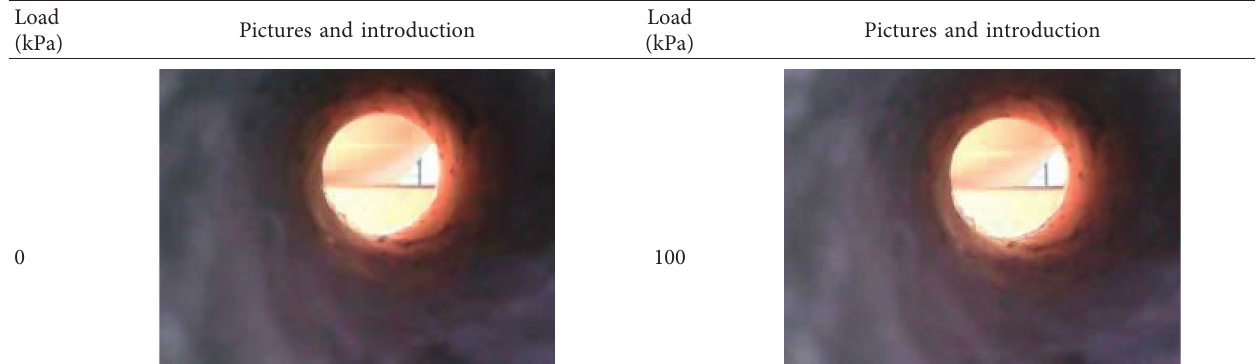
Table 2: Failure modes of drilling holes under different vertical